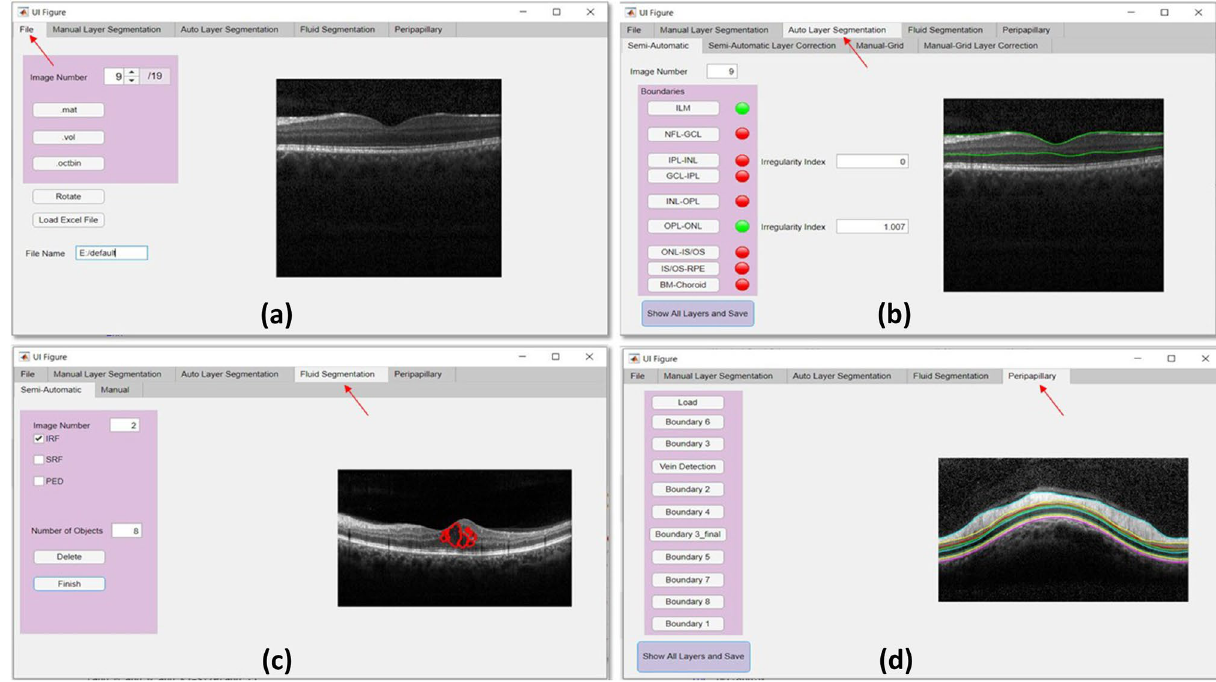
Figure 1. The proposed software’s major tabs ( a ) the file tab, ( b ) the auto layer segmentation tab, ( c ) the fluid segmentation tab, ( d ) the peripapillary